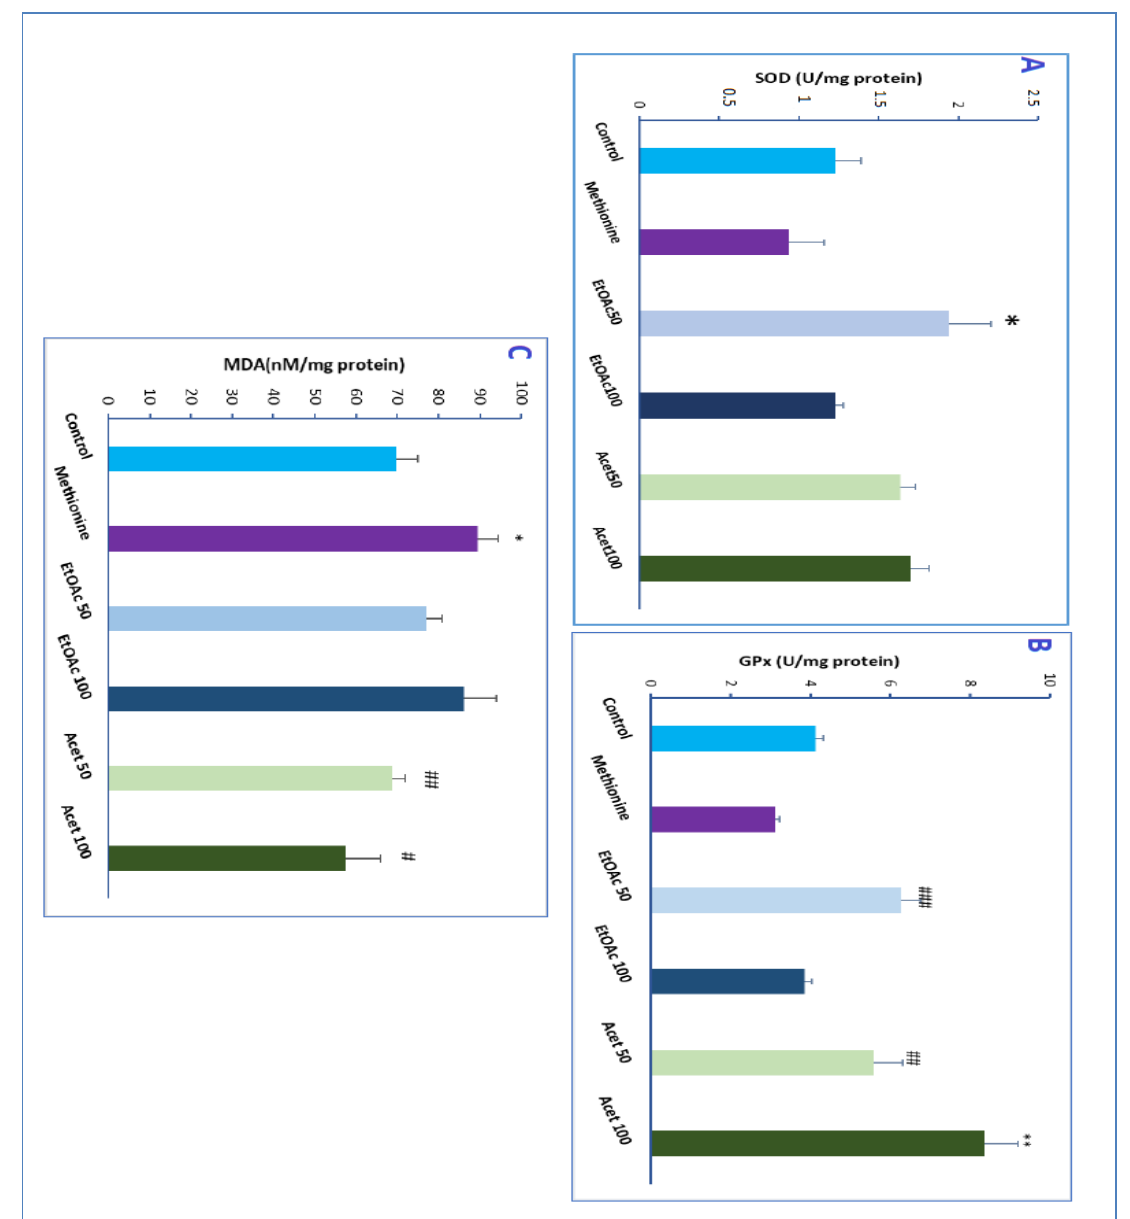
Figure 6. Effect of CSP extracts administration (Ethyl acetate and Acetone (EtOAc 50 and 100 mg/kg) on SOD-specific activity ( A ), GPx-specific activity ( B ), and on MDA level ( C ) vs. methionine and control groups. Values mean ± SEM with * p ≤ 0.05, ** p ≤ 0.01 compared with control and # p ≤ 0.05, ## p ≤ 0.01, and ### p ≤ 0.001 vs. methionine group.